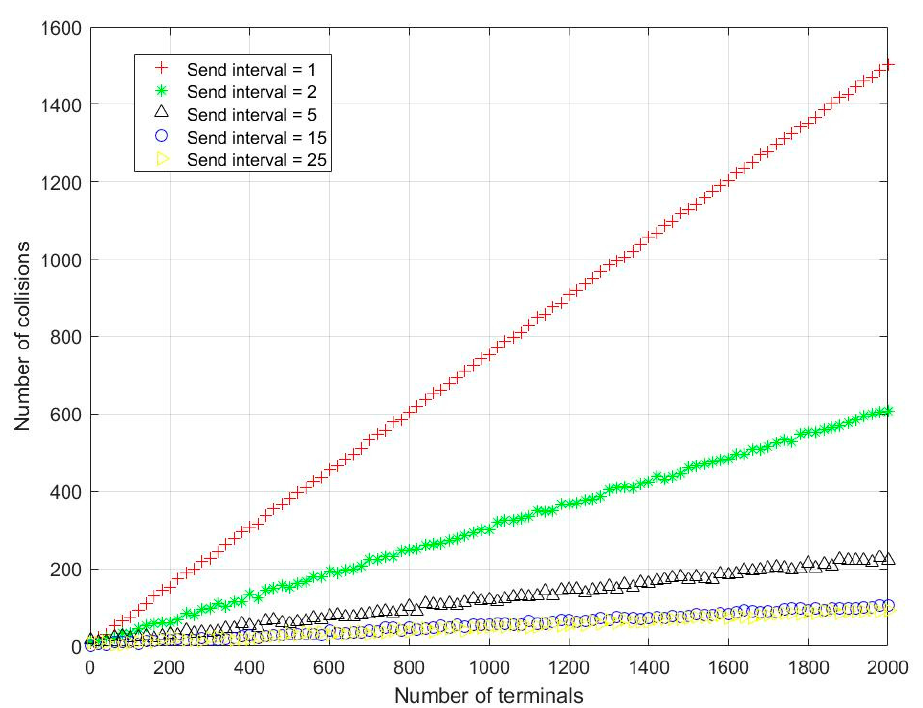
Figure 5. Number of collisions under different numbers of terminals in LEO satellite beam-hopping IoT access scenario.